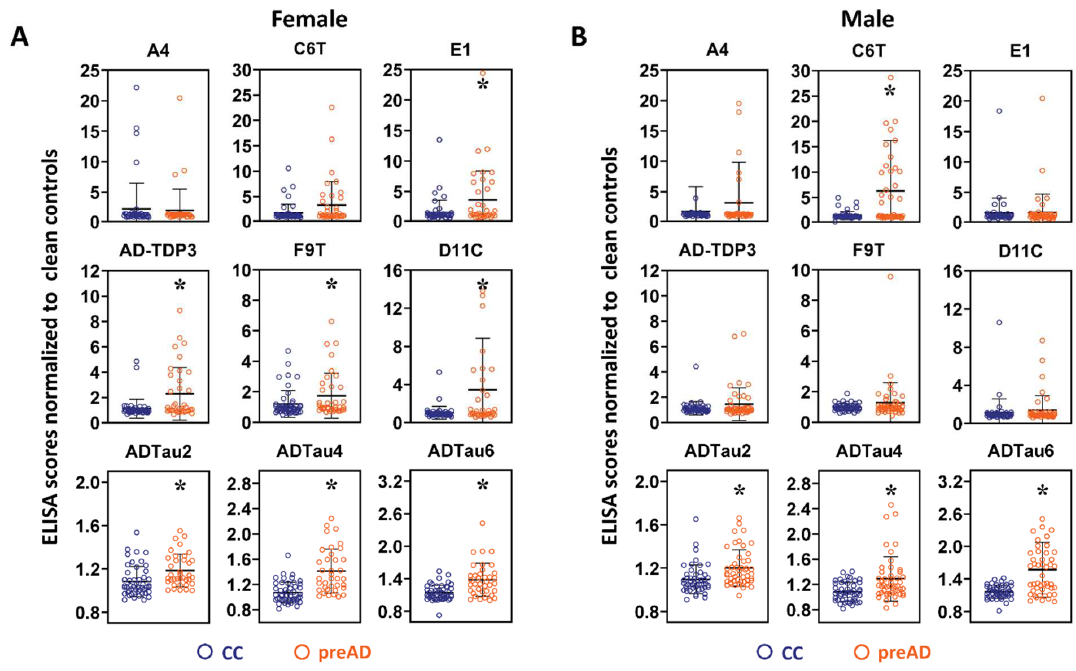
Figure 6. Sex differences in preAD cases and unflagged control plasma sample significance. Levels of 9 different protein variants measured in preAD (preMCI and MCI) time points in 25 AD cases and 20 unflagged control cases separated by sex. ( A ) The preAD samples from female AD cases showed significant differences between female control cases with seven of nine scFvs: Aβ (E1), TDP-43 (AD-TDP3), and tau (F9T, D11C, ADTau2, ADTau4, and ADTau6). ( B ) The preAD samples from male AD cases showed significant differences between male control cases with four of nine scFvs: A β (C6T) and tau (ADTau2, ADTau4, and ADTau6). Data represent mean average score and standard deviation with statistical significance by ANOVA post hoc LSD * p < 0.05. CC denotes clean controls as unflagged control